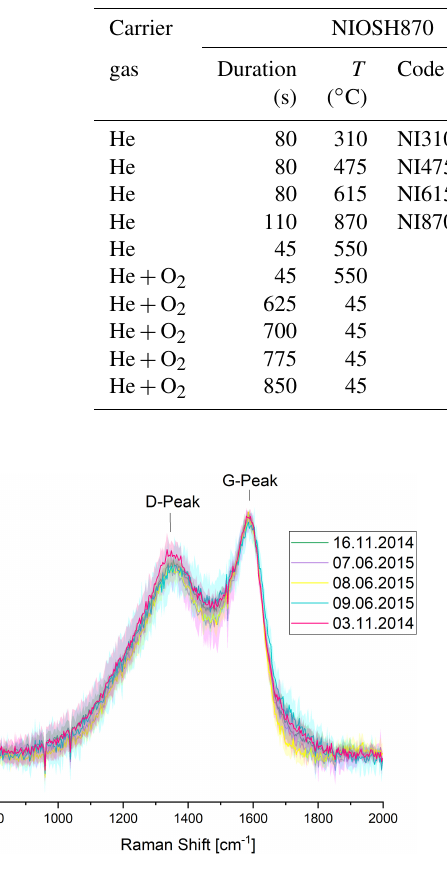
Figure 1. Raman spectra for a representative subset of original (un- heated, unwashed) samples. Error bars (standard deviation of the mean spectra) are displayed as shaded areas. The spectra are simi- lar among themselves within their error bars especially in the peak heights. For a better illustration, only five spectra were selected. All other spectra of original samples are comparable within their error